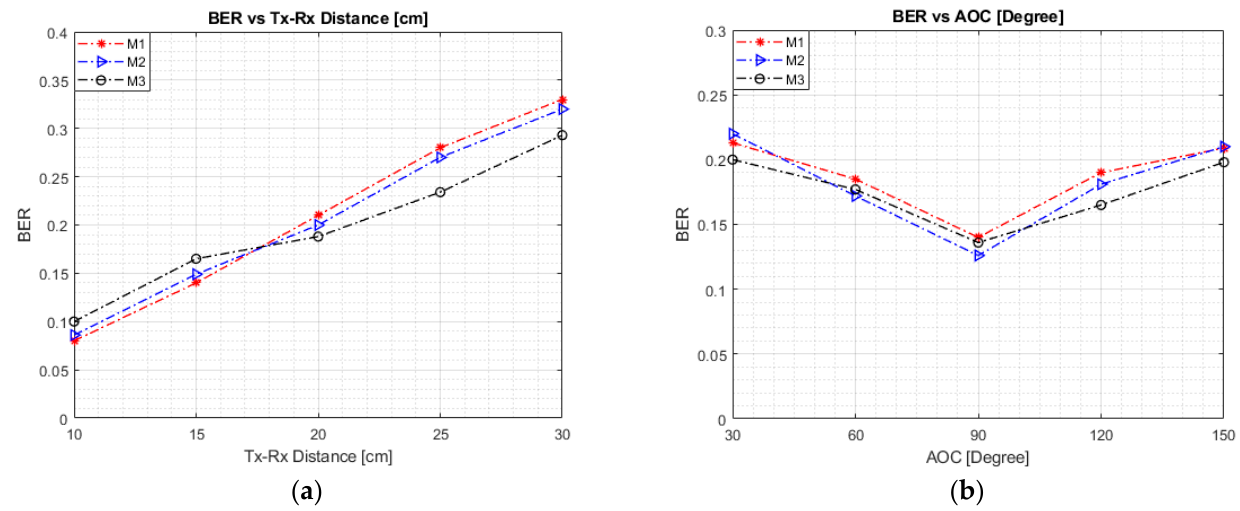
Figure 10. The BER performance of the proposed system ( a ) by distance ( D ) and ( b ) angle of capture ( AOC ).